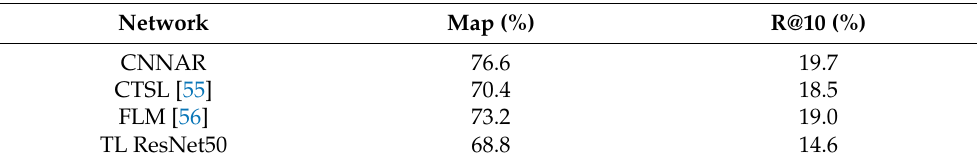
Table 2. Retrieval accuracy of different methods on the image datasets of diaspora Chinese architec- tural